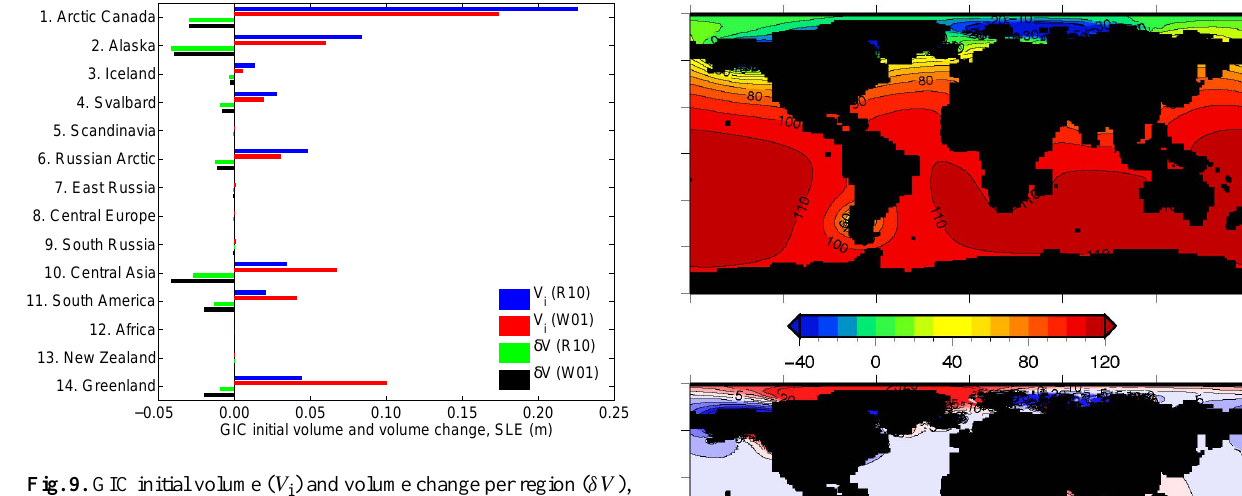
Fig. 11: GIC sea-level contribution (m) for the 12 climate models and the two glacier inventories (1990-2090). Dashed lines represent model mean contribution for each inventory.